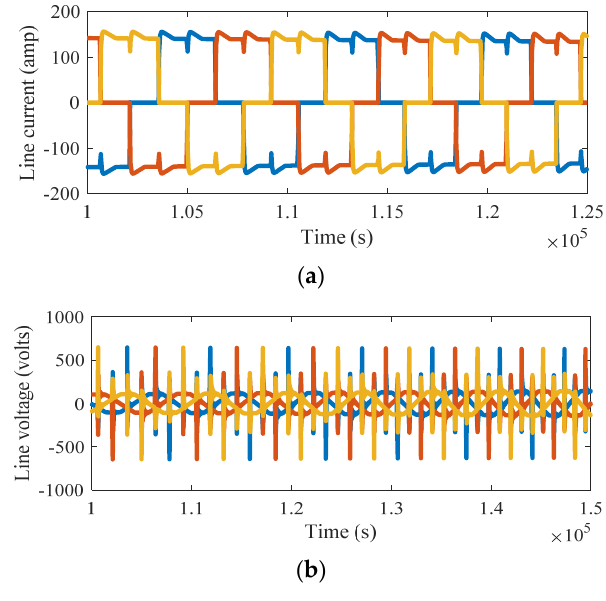
Figure 12. DC Bus values ( a ) Voltage vs Time and ( b ) Current Vs Time.